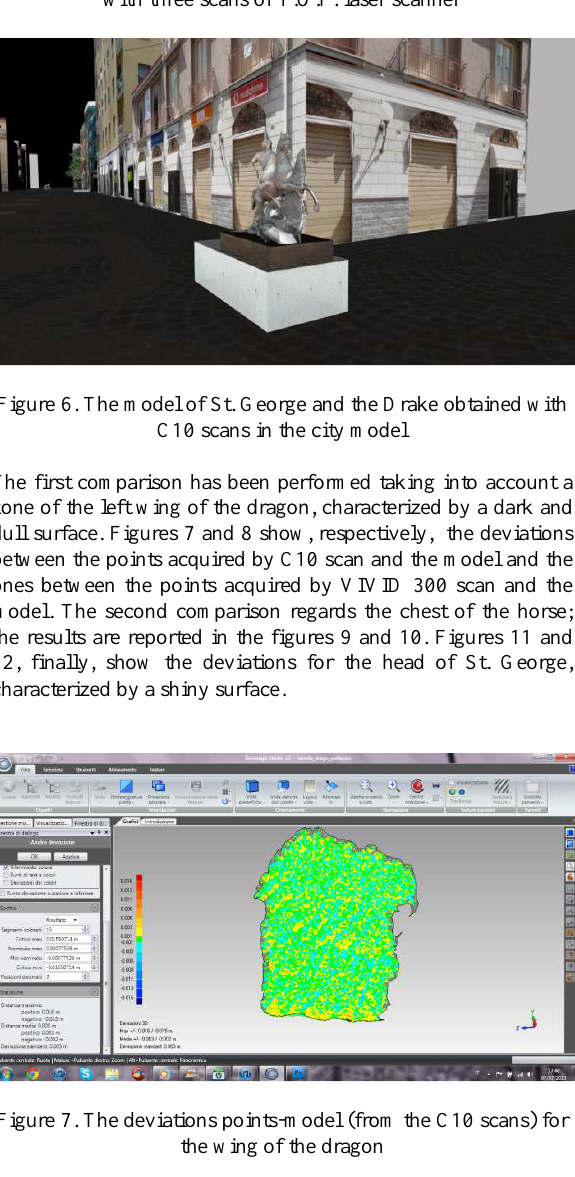
Figure 5. The point cloud of St. George and the Drake obtained with three scans of T.O.F. laser scanner